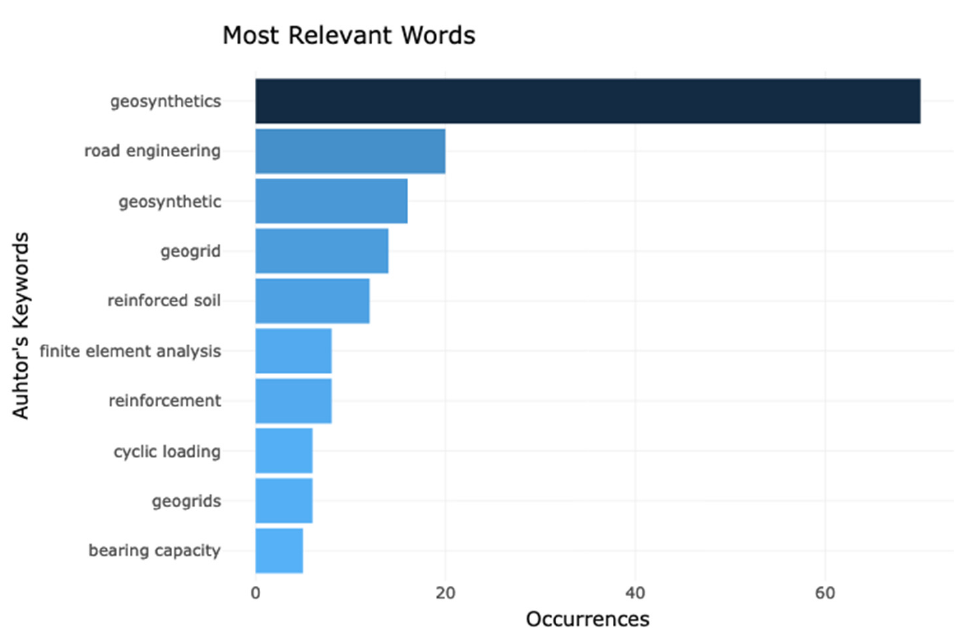
Figure 19. Co-occurrence network.